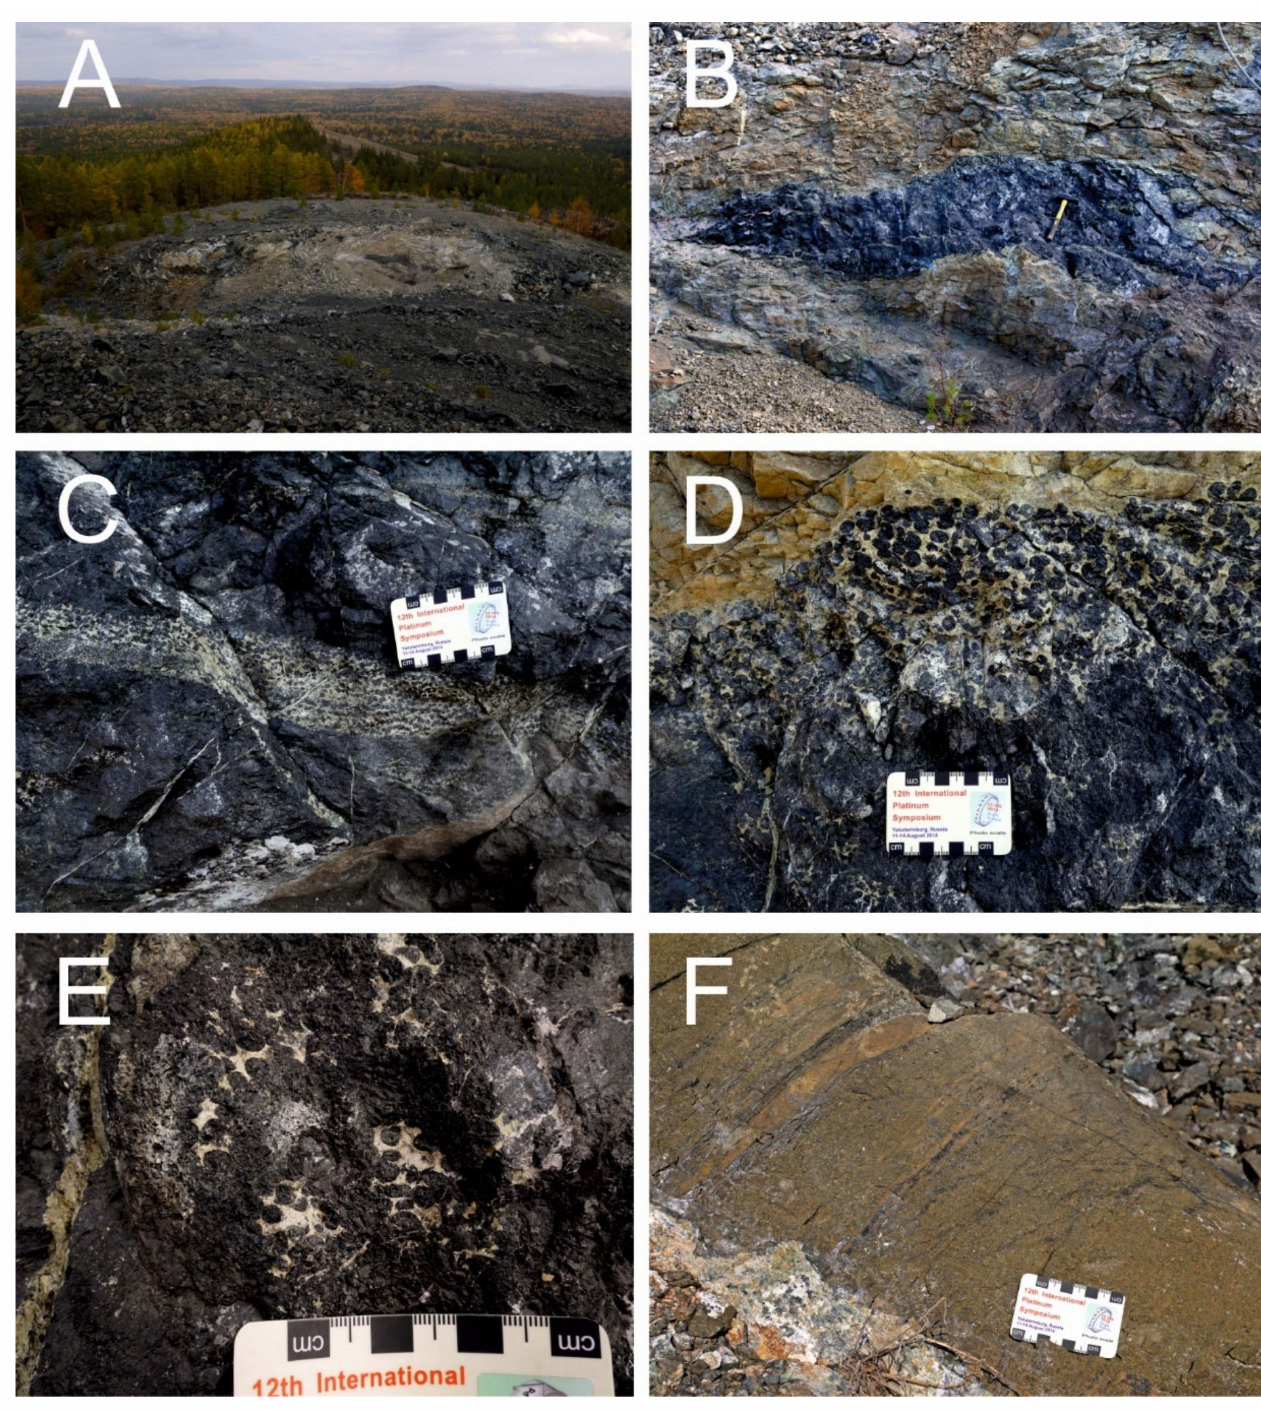
Figure 3. Field images of the Prospect 33 chromite deposit. View of the exploration open pit ( A ). A massive lens of chromitite in sharp contact with the host dunite ( B ). Irregular pods of high-grade disseminated ore inside massive chromitite ( C ). Nodular ore composed of 1–2 cm chromite spherules ( D , E ). Ore-hosting lherzolite-dunite interbedded sequence. Dunite = yellow; lherzolite = gray-yellowish; dark layers are strongly serpentinized zones ( F ). Photographs by E.